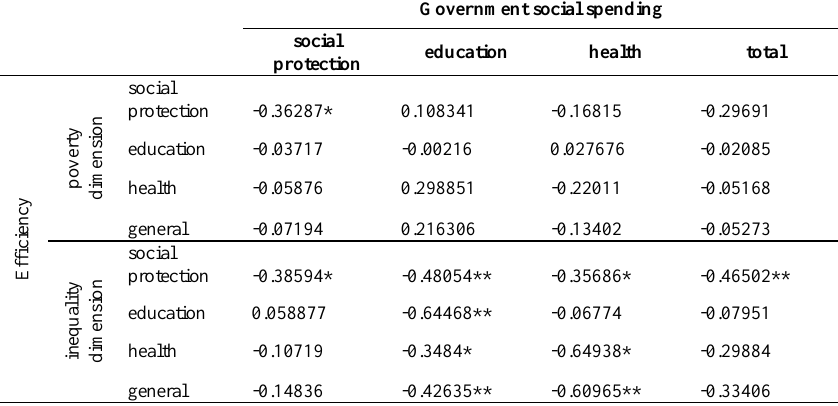
Table 1. Correlation between a scale of government social spending and their efficiency in limiting poverty and income inequality in the EU